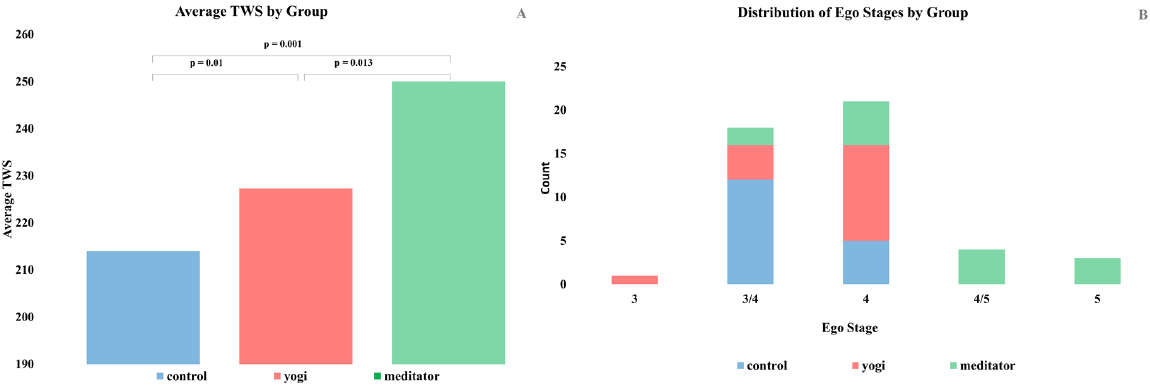
Figure 1. ( A ) Differences in mean TWS between groups. Mean TWS for each group is shown along with the p -values from the Games–Howell tests, which show that TWS is higher for meditators and yogis than controls and higher for meditators than yogis. ( B ) Distribution of stages between groups. The distribution of ego stages for the sample is shown. Stage 4 is the Conscientious stage, which is the last of the conventional stages.